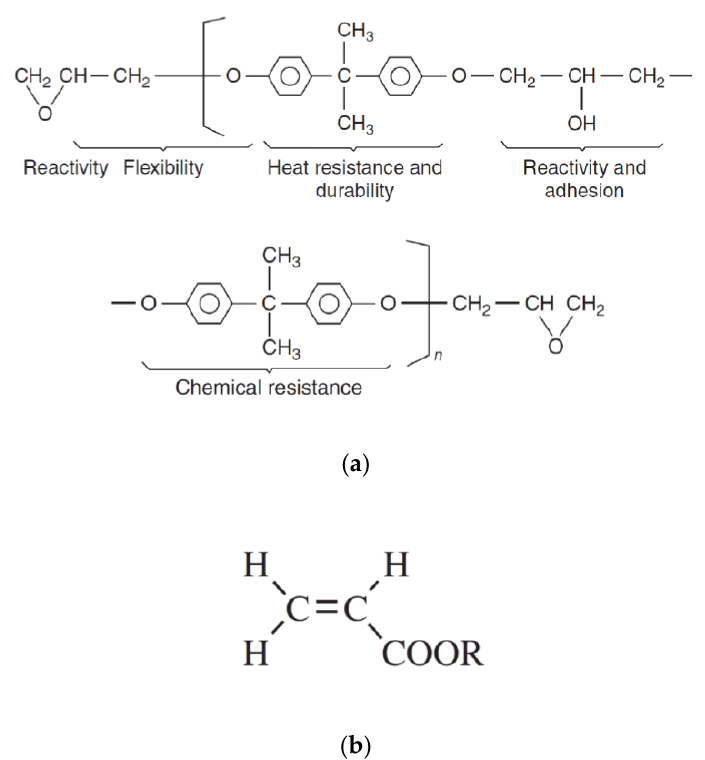
Figure 1. The structure and properties of ( a ) epoxy resins and ( b ) acrylic polymers